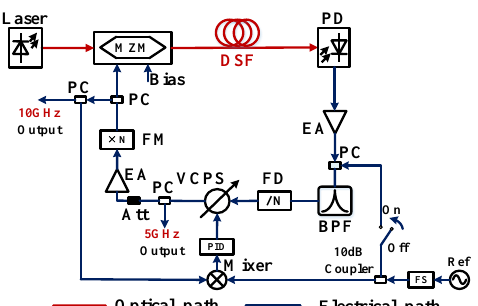
Figure 15. Schematic diagram of the stabilized OEO scheme based on the FCP with equivalent wide